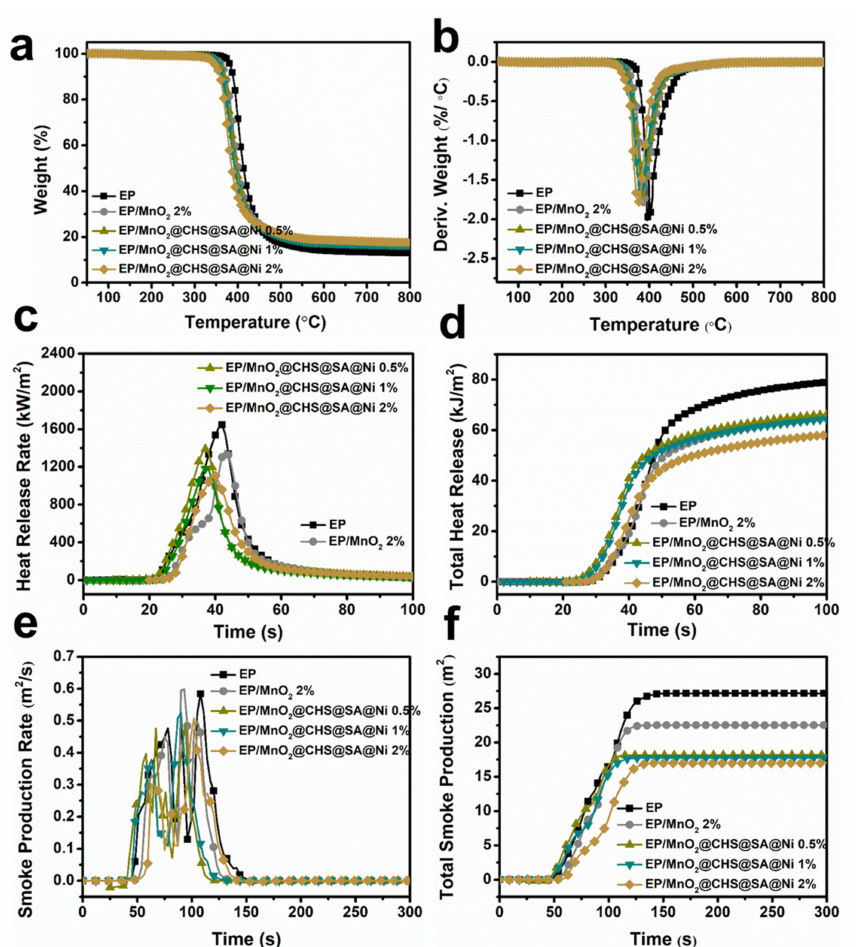
Figure 3. Thermal stability and fire resistance of control epoxy and its composites. ( a ) TGA, ( b ) DTG curves under nitrogen atmosphere, ( c ) heat release rate, ( d ) total heat release, ( e ) smoke production rate and ( f ) total smoke production versus time curves of pristine EP, EP/MnO 2 and EP/MnO 2 @CHS@SA@Ni